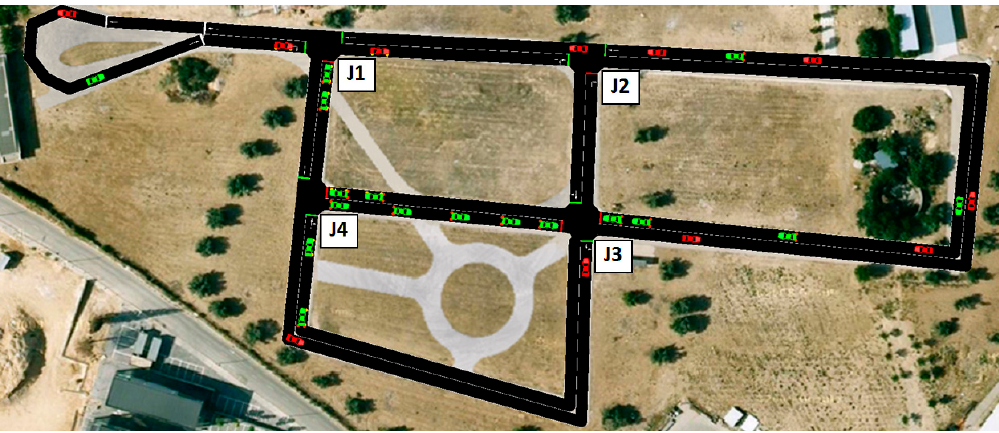
Figure 4. Simulated road network. Table 3. Vehicle and car-following model parameters.